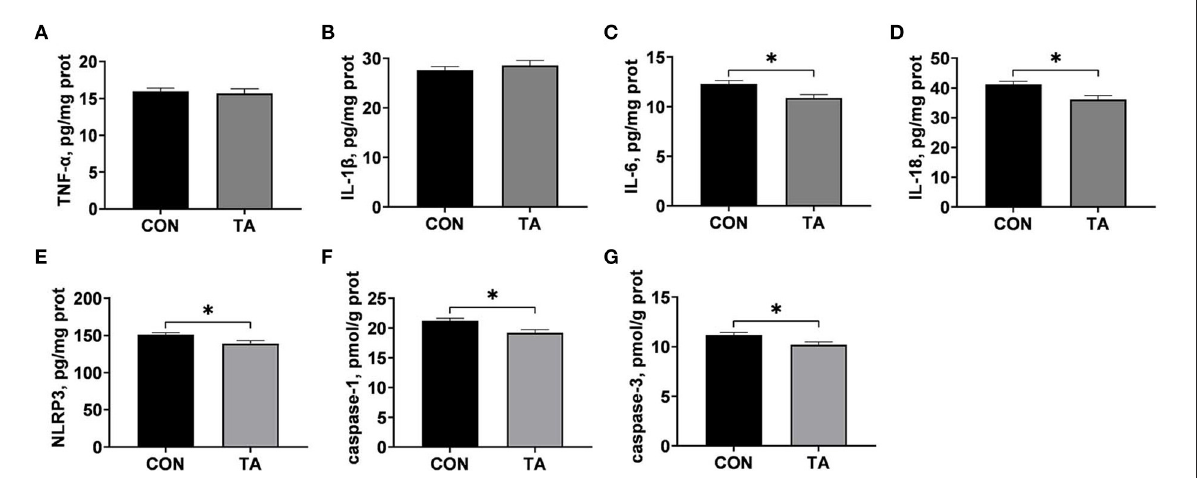
FIGURE4 Effects of dietary supplemented with microencapsulated TA from Galla Chinensis on liver inflammatory factor and hepatic caspases levels of broiler chickens. (A) Tumor necrosis factor- α (TNF- α ), (B) Interleukin-1 β (IL-1 β ), (C) Interleukin-6 (IL-6), (D) Interleukin-18 (IL-18), (E) NLRs family